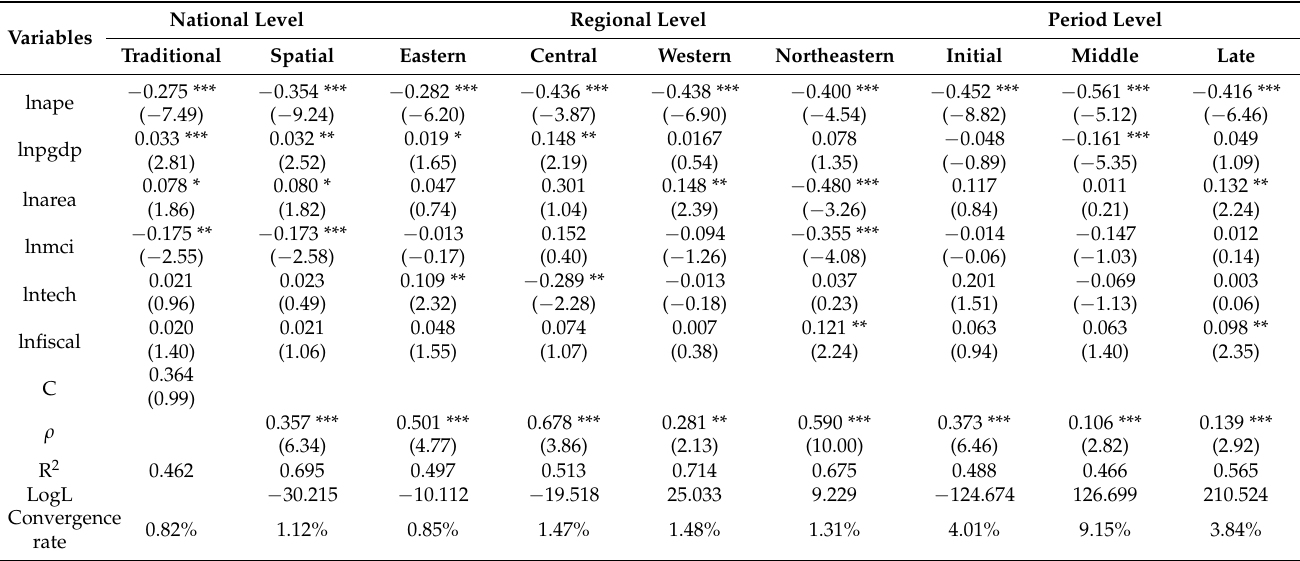
Table 5. Spatial β conditional convergence test of APE under the dual constraints of climate change and resource